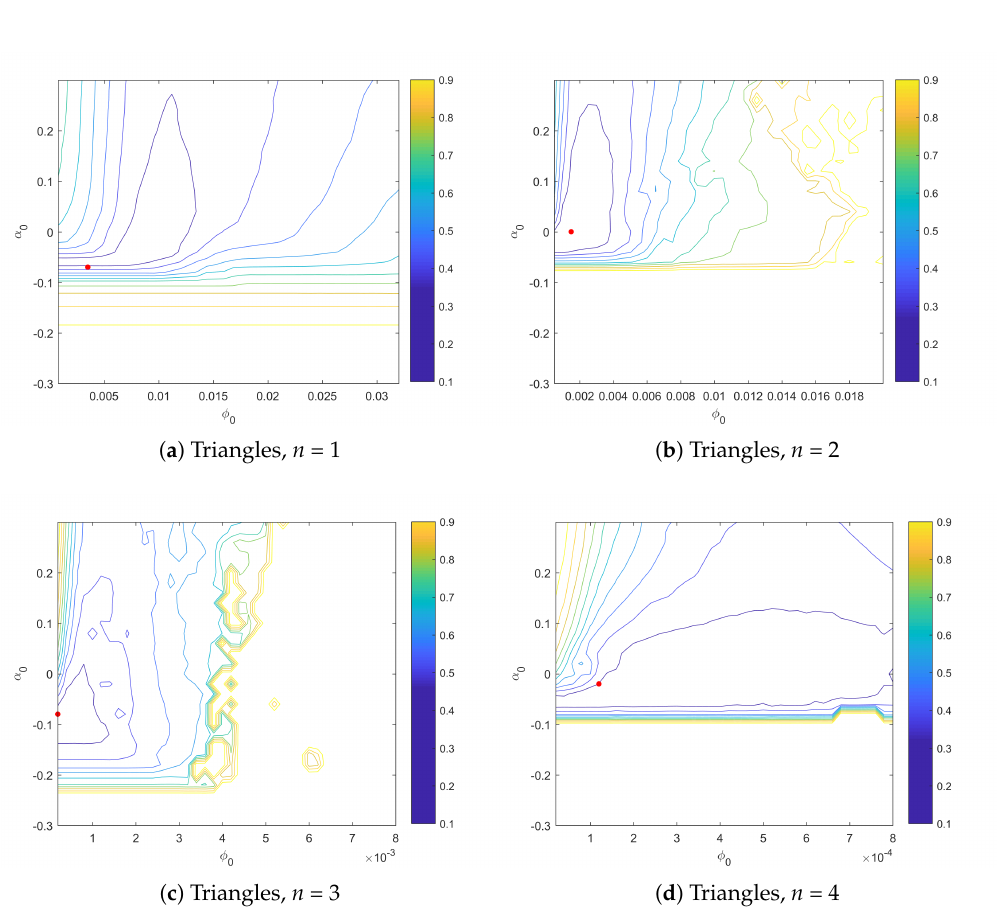
Figure 2. Normalized L 2 errors in density for the Shu–Osher problem for each polynomial order of triangular elements. Red dots are selected design points for α 0 and φ 0 . For diverged simulation cases, the normalized L 2 error values are replaced with the maximum L 2 error value among stable